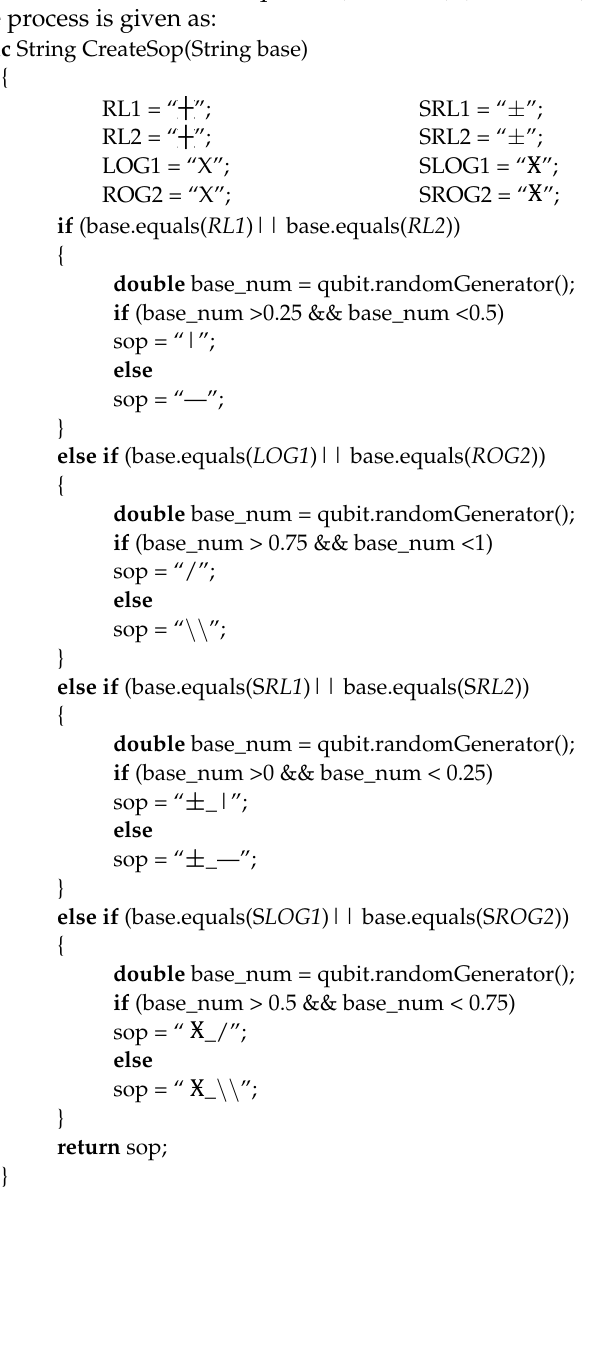
Table 3. BB84 qubit SOP-based encrypting design.